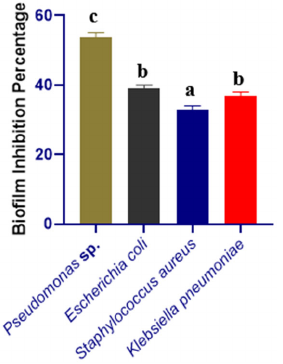
Figure 1. Biofilm ‐ inhibition percentage of Klebsiella pneumoniae , Pseudomonas sp., Escherichia coli , Staphylococcus aureus by the CFS of Bacillus subtilis . Different letters indicate significant differences between mean ± SD of replications ( n = 3) at a p < 0.05 significance level.